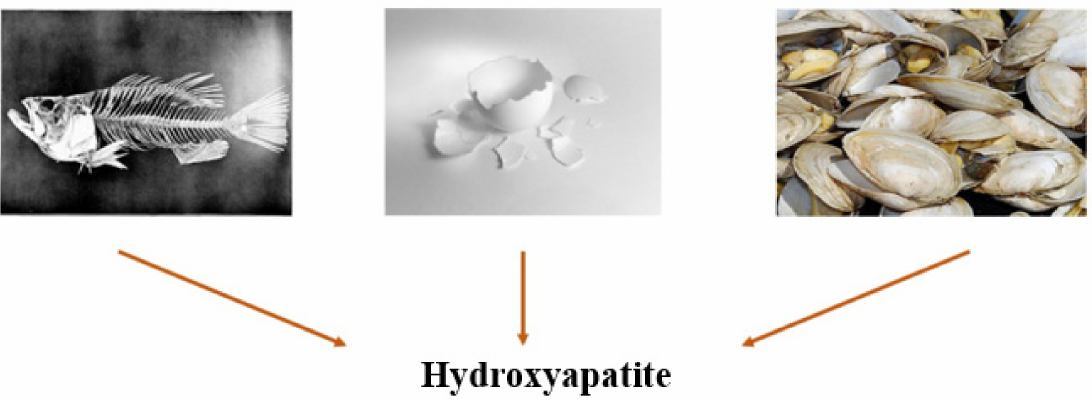
Figure 3. Natural sources of CaPs.